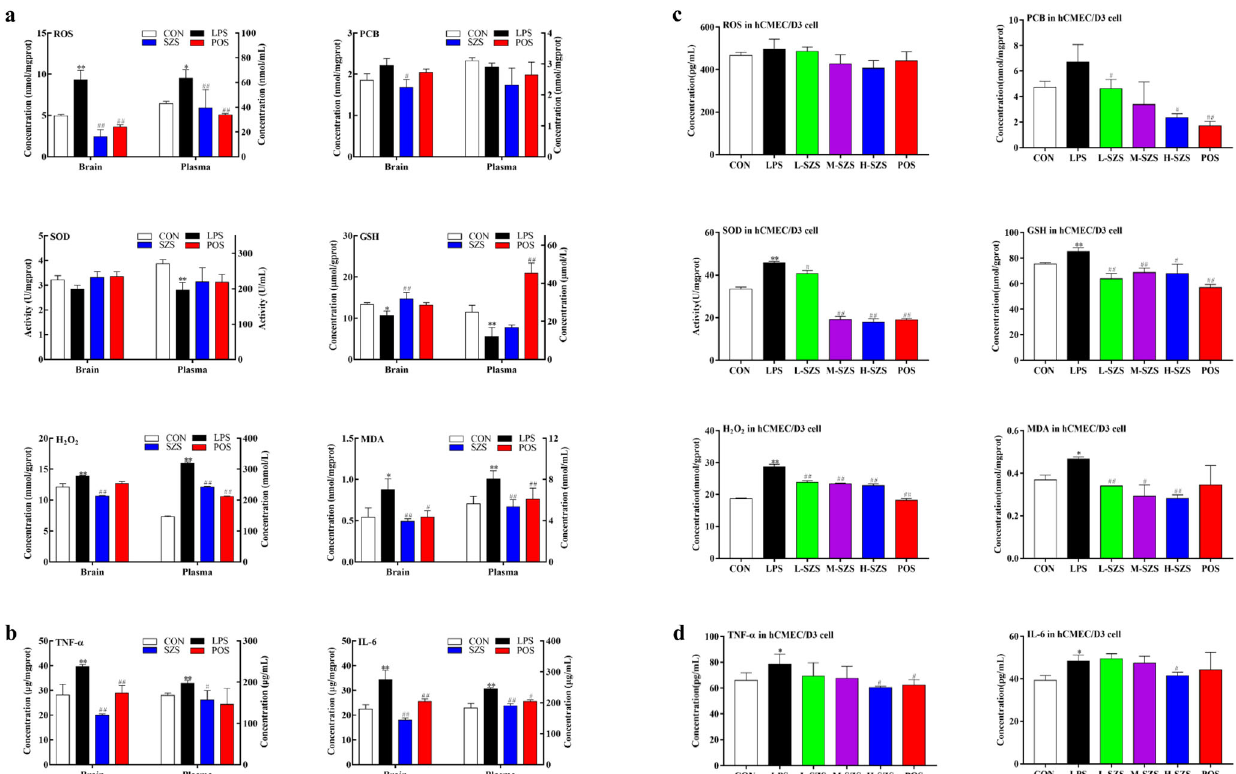
of the gray value of the target band to that of the total proteins in the same sample 15 . The gel images for total protein are shown in Supplementary Fig. S1. Occludin, β -catenin, and P-gp expression in the rat cortex following LPS exposure was dramatically decreased ( P < 0.05). SZS elevated the expression of β -catenin ( P < 0.05), occluding, and P-gp (without signi fi cance) compared with the LPS group. No signi fi cant change in ZO-1 expression was observed in rats exposed to LPS or SZS. Vc as the positive control upregulated β -catenin expression. SZS increased the expression of junction proteins and P-gp, which may be useful for improving junction structures and maintain BBB integrity. Expression of all TJ and AJ proteins and P-gp was signi fi cantly decreased in LPS-treated hCMEC/D3cells ( P < 0.05, Fig. 3b) compared with the CON group. SZS (50, 100, and 200 μ g/mL) treatment signi fi cantly upregulated the expression of ZO-1 ( P < 0.01) and β -catenin in a dose-dependent manner. SZS at the highest dose (200 μ g/mL) increased the expression of E-cadherin and P-gp by 9.07% and 19.9% ( P < 0.05), respectively. Three doses of SZS and Vc slightly increased occludin expression. An immuno fl uorescence (IF) assay indicated that the three doses of SZS increased occludin (Fig. 3c), ZO-1 (Fig. 3d), and E-cadherin (Fig. 3e) expression in a dose-dependent manner compared with LPS-treated hCMEC/D3 cells. SZS improved the distribution of occludin and ZO-1, whereas no signi fi cant in fl uence on E-cadherin was evident. Collectively, SZS protects BBB integrity by increasing the expression of junction proteins and P-gp. SZS signi fi cantly regulated rat cortex proteins based on proteomics A total of 3998 proteins were identi fi ed based on a label-free proteomic strategy, which is shown by volcano plots (Fig. 4a,